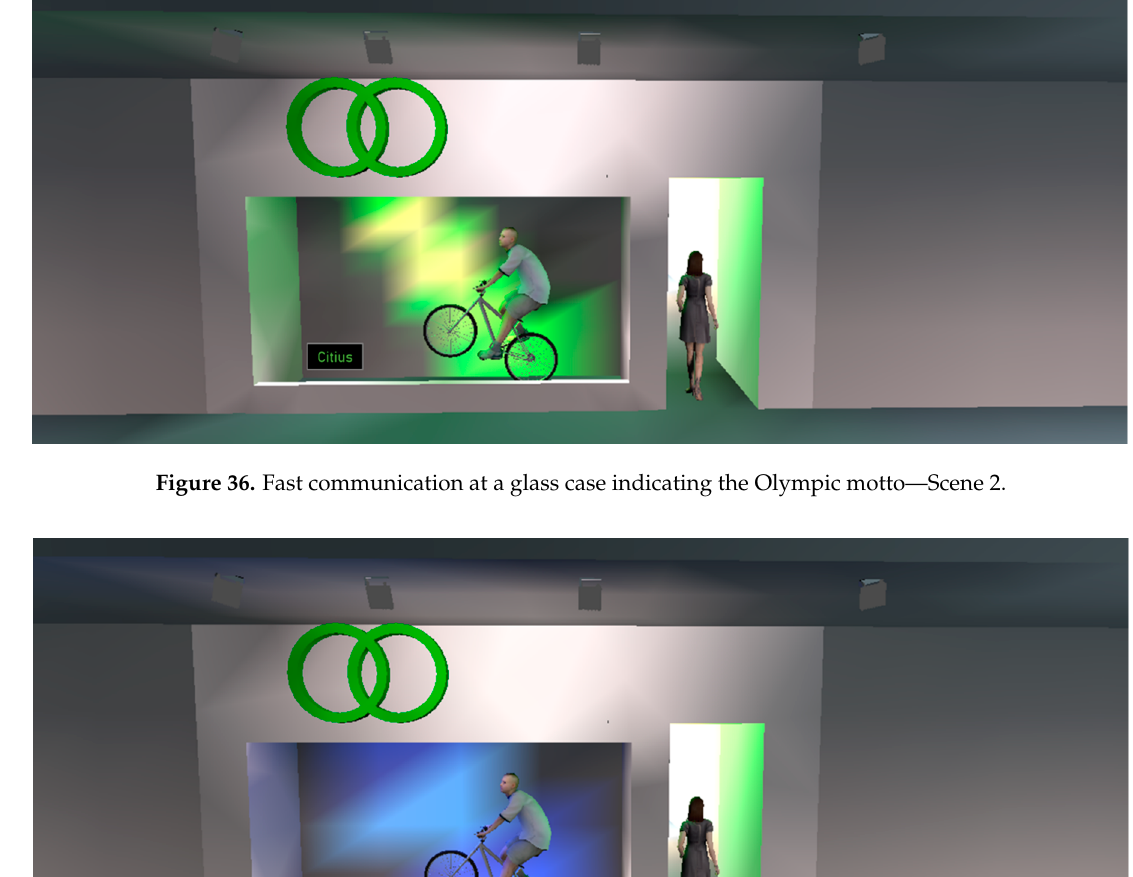
Figure 35. Fast communication at a glass case indicating the Olympic motto—Scene 1.